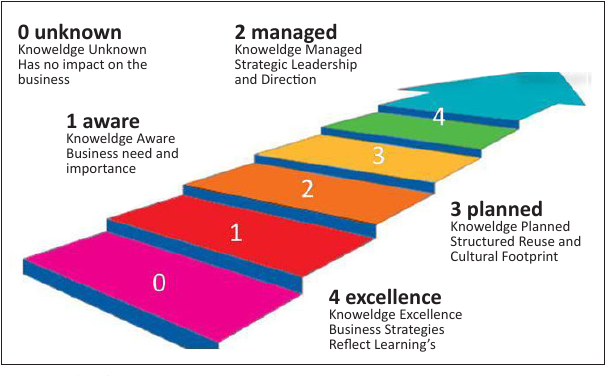
FIGURE 5: The MultiChoice Maturity